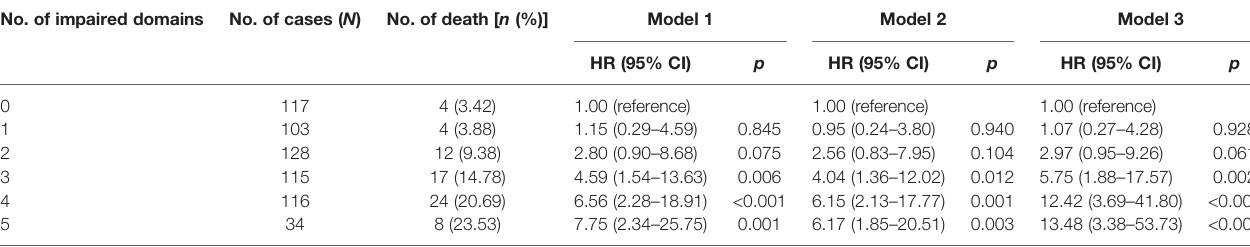
Model 1: unadjusted. Model 2: adjusted for age, gender, history of diabetes, hypertension, coronary heart disease, and stroke, medication of ACEI/ARB, aspirin and insulin, body mass index,dialysisvintage, Kt/V,hemoglobin, serumlevelsofalbumin,totalcholesterol,triglycerides, calcium,phosphate,intactparathyroidhormone,C-reactive protein,beta2-microglobulin, and eGFR. Model 3: based on model 2, adjusted for the cognitive function of 5 domains.